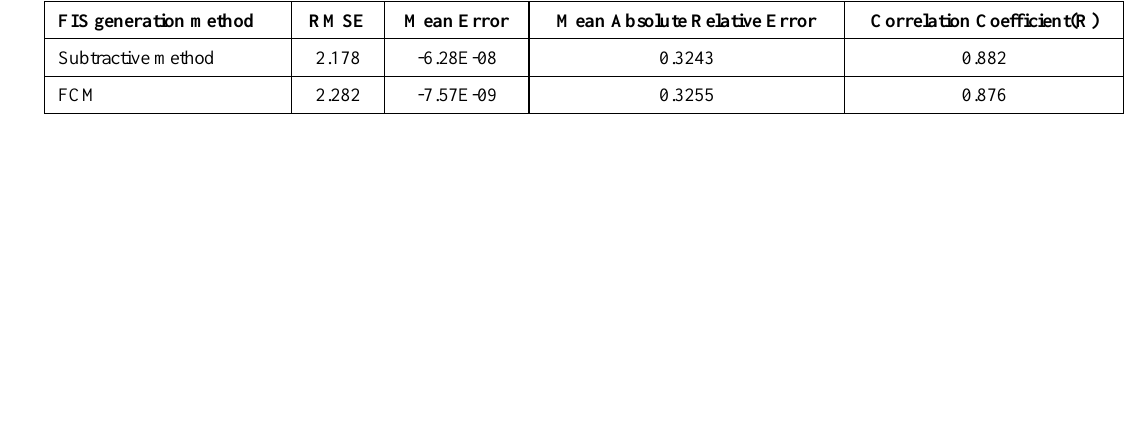
Table 7. Results of evaluating different ANFIS models for training